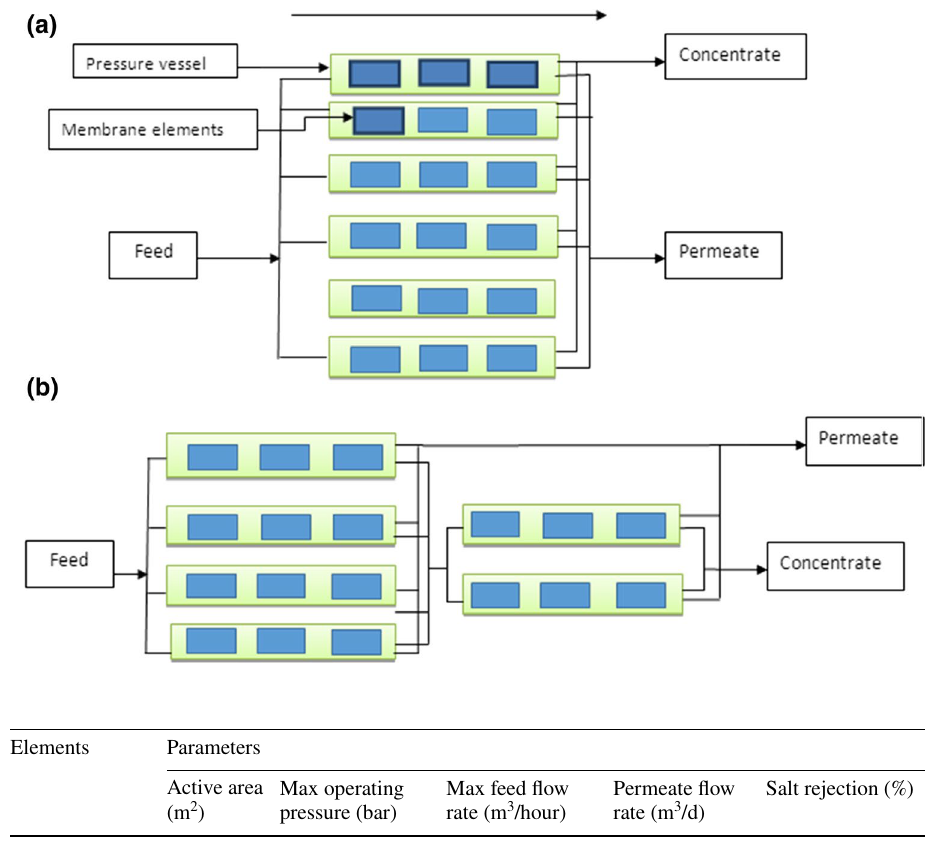
Fig. 1 Schematic design of RO/NF configuration process.